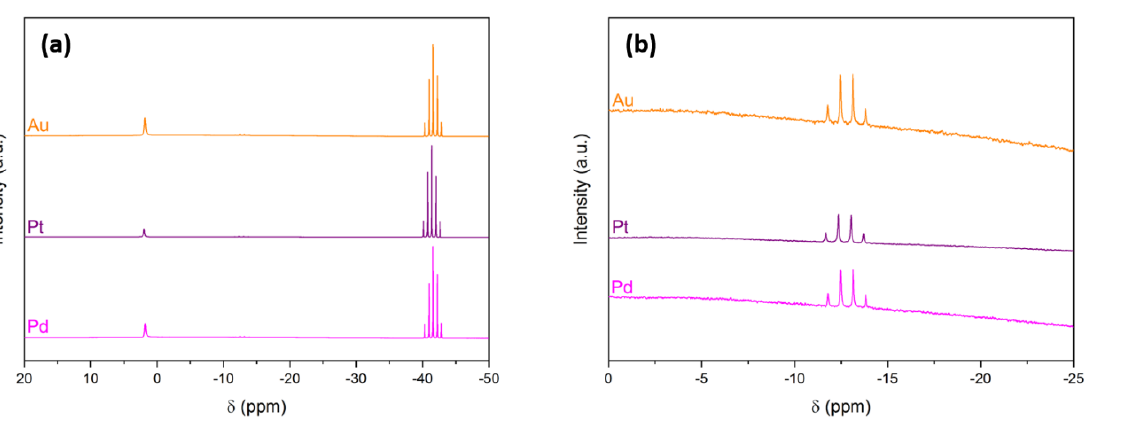
50 mg NaBH 4 in 2 mL) upon H 2 evolution catalyzed by Pd, Pt, or Au at 30 ◦ C. ( a ) Range between δ +20 and δ − 50 ppm. ( b ) Focus on the range between δ 0 and − 25